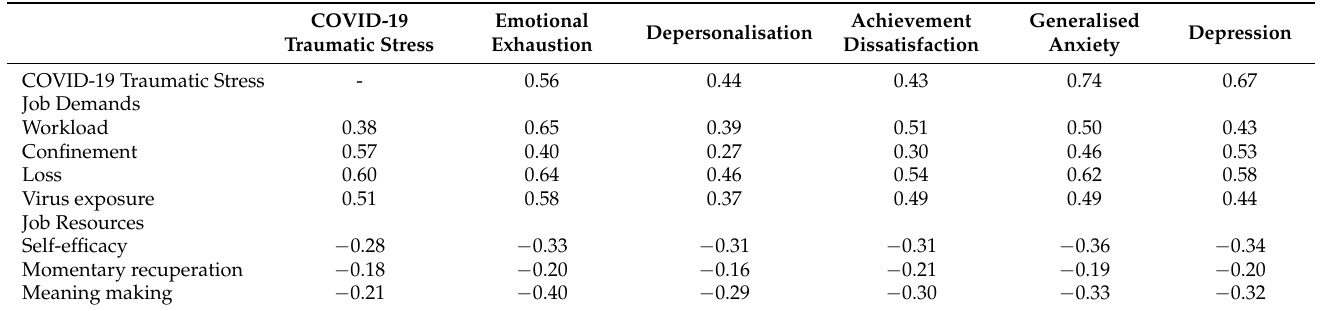
Table 2. Bivariate correlations of the latent job demands and job resources with the latent distress indicators.